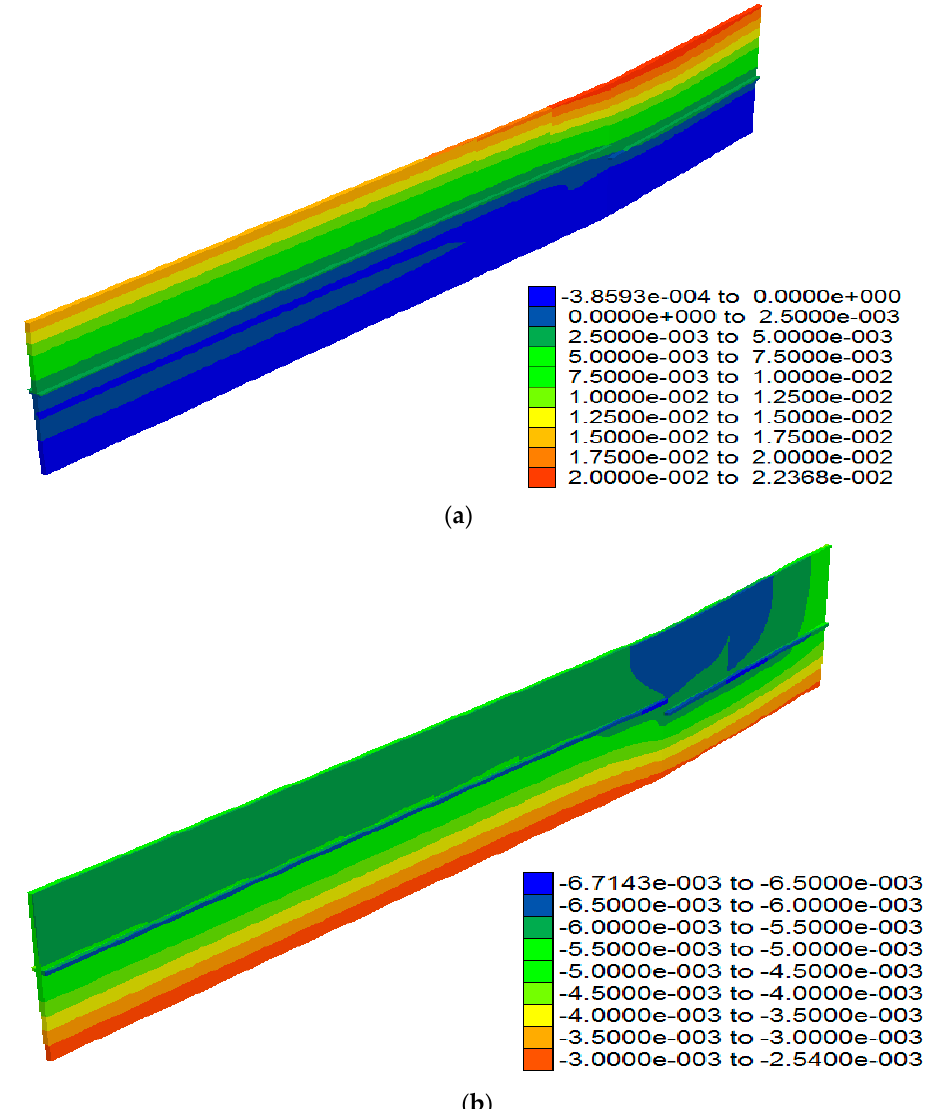
Figure 10. The overall deformation of cut-off wall. ( a ) horizontal displacement of cut-off wall. ( b ) vertical displacement of cut-off wall.